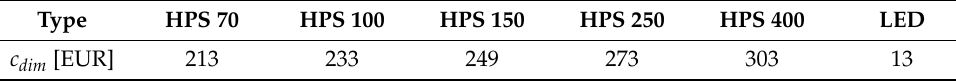
Table 9. The cost of dimming equipment installation.